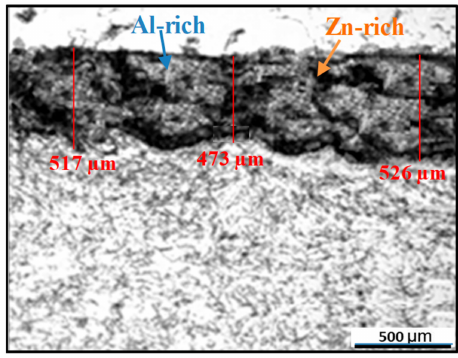
Figure 2. Cross-section microstructure of coated